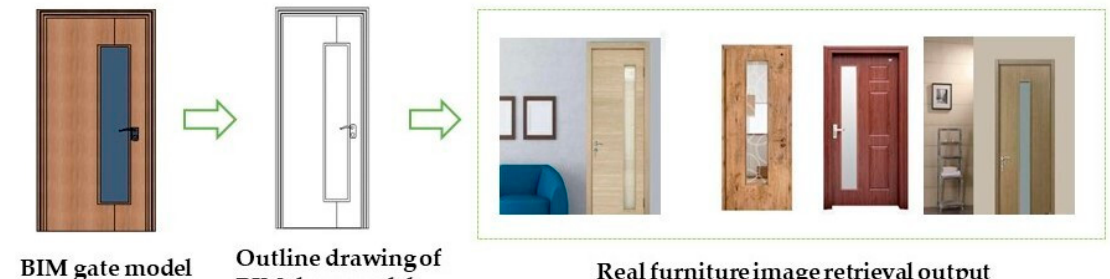
Figure 7. Example of the retrieval result of the BIM door model outline